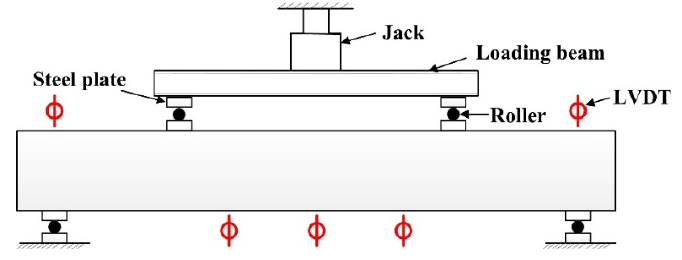
Figure 3. Loading diagram of experimental beam.